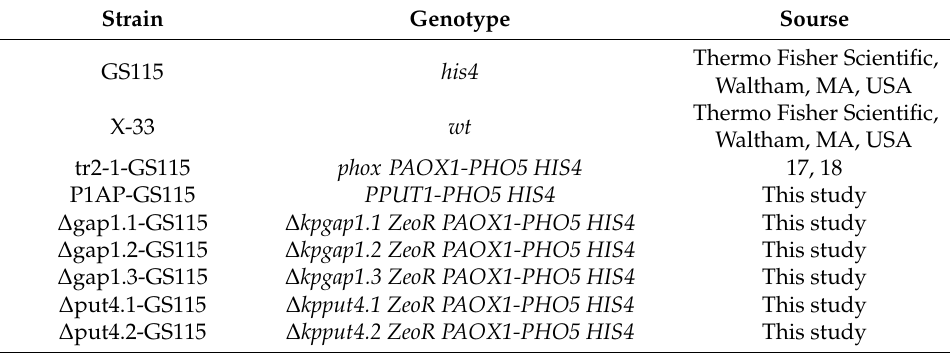
Table 1. K. phaffii strains used in this